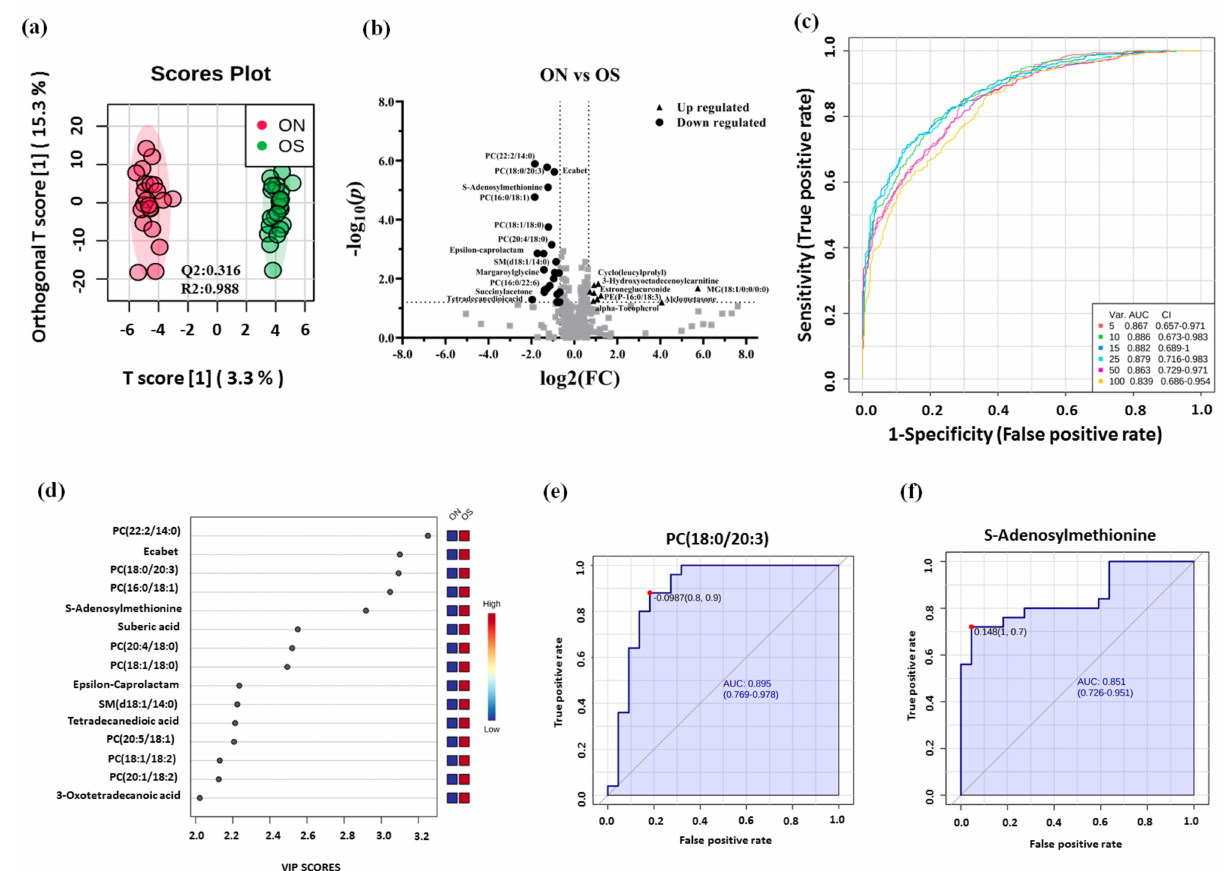
Figure 4. Metabolomics profiling and biomarker evaluation between ON and OP. ( a ) An OPLS-DA analysis of the metabolomics profile of ON versus OP groups showing the separation between these two groups ( Q 2 = 0.316, R 2 = 0.988). ( b ) Volcano plot showing the statistically significant dysregulated metabolites (FDR-corrected p -value < 0.05, and FC >1.5 or <0.67). The levels of 12 metabolites were upregulated, whereas 24 were downregulated in ON compared to the OP group. ( c ) An exploratory ROC curve was generated by the OPLS-DA model, with AUC values calculated from the combination of five, 10, 15, 25, 50, and 100 proteins. ( d ) Frequency plot showing 15 positively identified metabolites. ( e , f ) Representative area under the curve (AUC) for two significantly dysregulated metabolites ( S -adenosylmethionine, AUC = 0.851, and phosphatidylcholines PC (18:0/20:3), AUC =